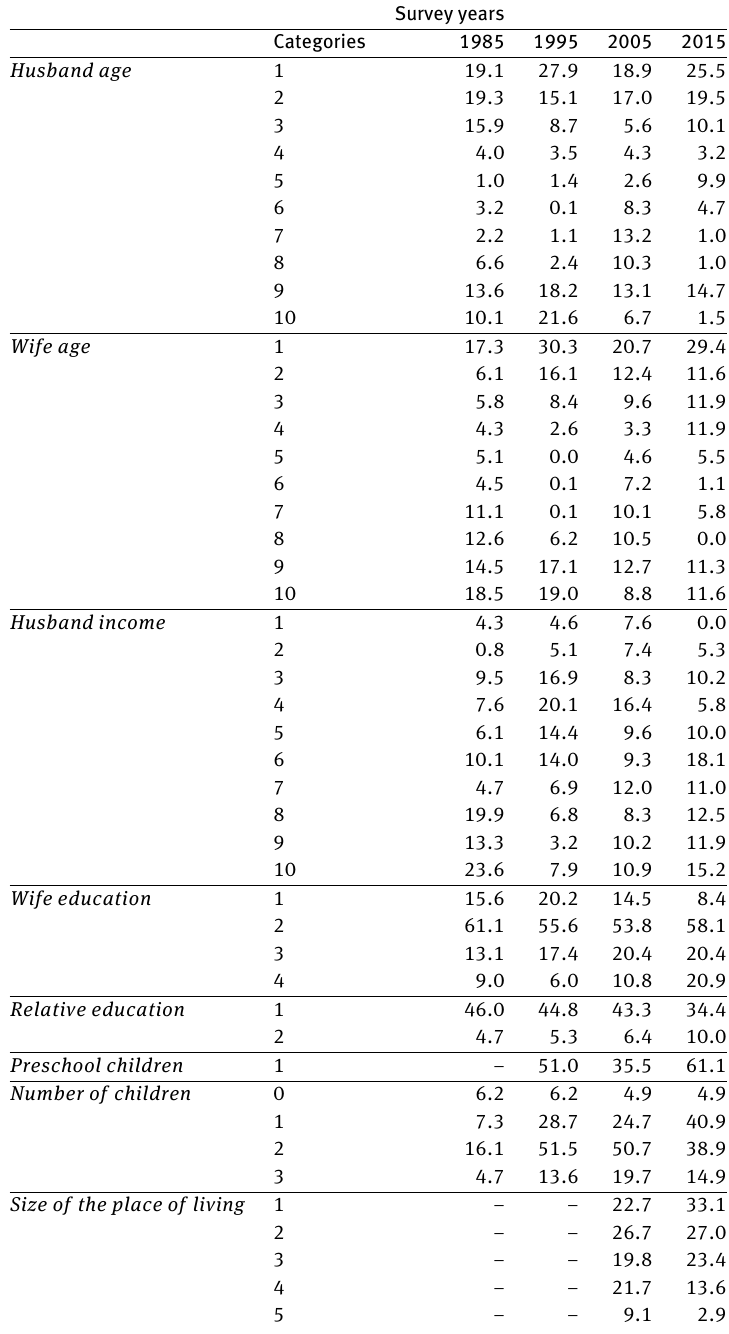
Table 7: Frequencies of the covariates (%) for couples predicted in U T (weighted with survey weights for years 2015 and 2005). The categories are defined in Table